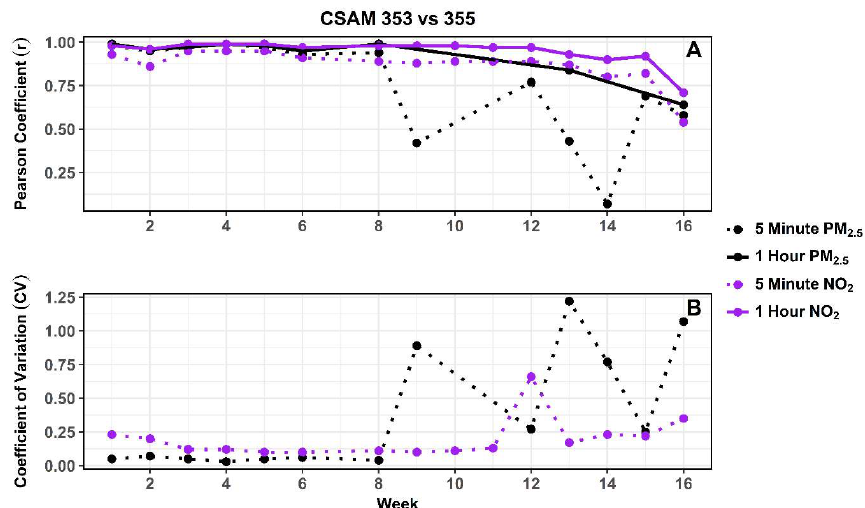
Figure 2. ( A ) Pearson coefficient (r) and ( B ) coefficient of variation (CV) calculated from 5 min (dashed line) and 1 h averaged (solid line) PM 2.5 (black dots) and NO 2 (purple dots) concentrations between